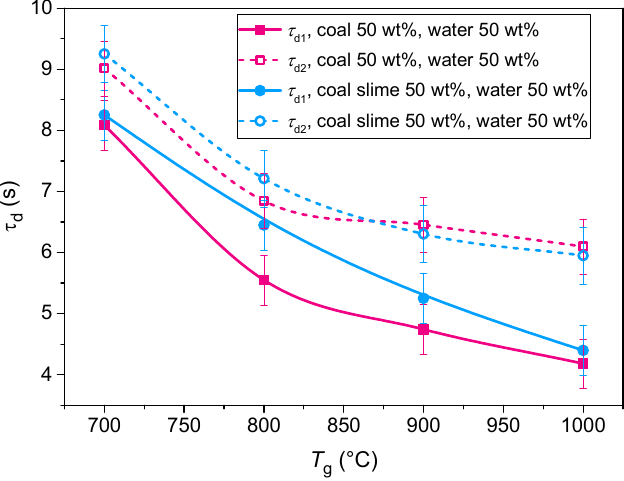
Figure 5. Gas-phase ignition delay (solid line) and heterogeneous ignition delay (dotted line) of coal–water slurry droplets with R d = 2 mm.